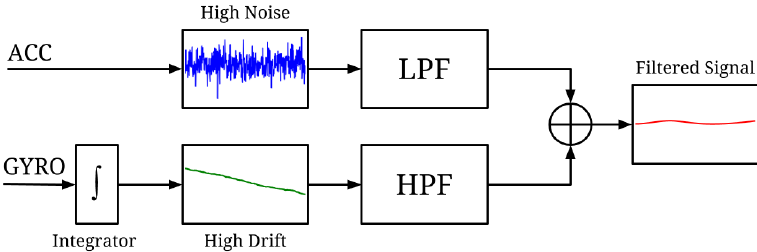
Figure 5. Working model of the Complementary Filter: Sensor fusion is performed on low-pass filtered accelerometer data and, after being integrated over time, high-pass filtered gyroscope data to obtain the filtered signal.